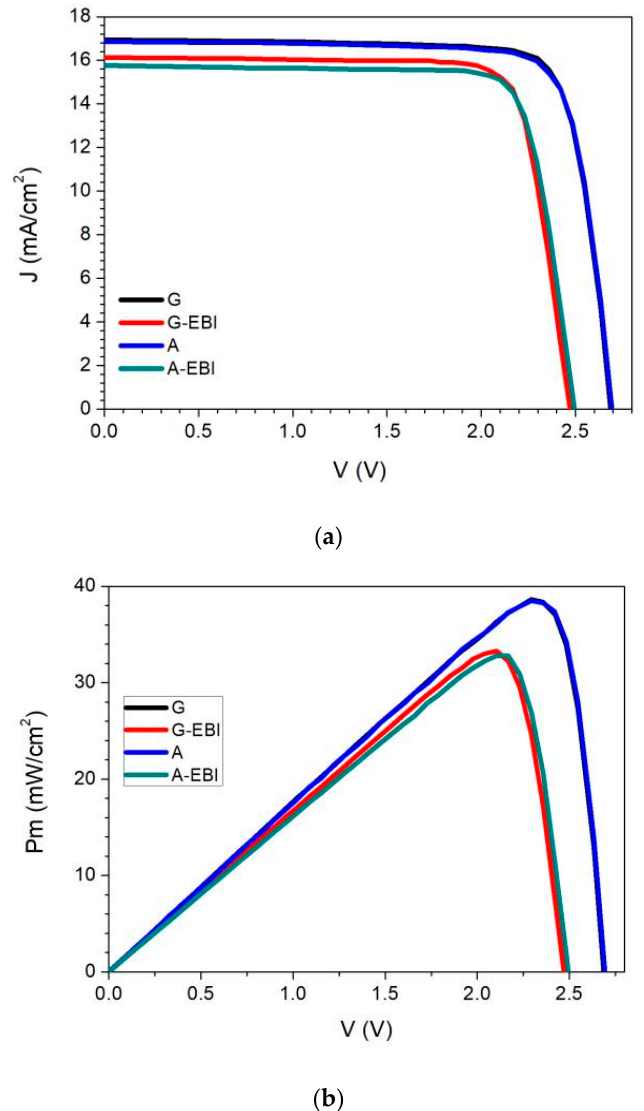
Figure 3. Light I-V characteristics before (G, A) and after electron beam irradiation (G-EBI, A-EBI): ( a ) Current density vs. voltage curve; ( b ) Power density vs. voltage curve. Table 1. Comparison of the I-V characteristics of the two types of solar cells before and after electron beam irradiation. Using GaInP